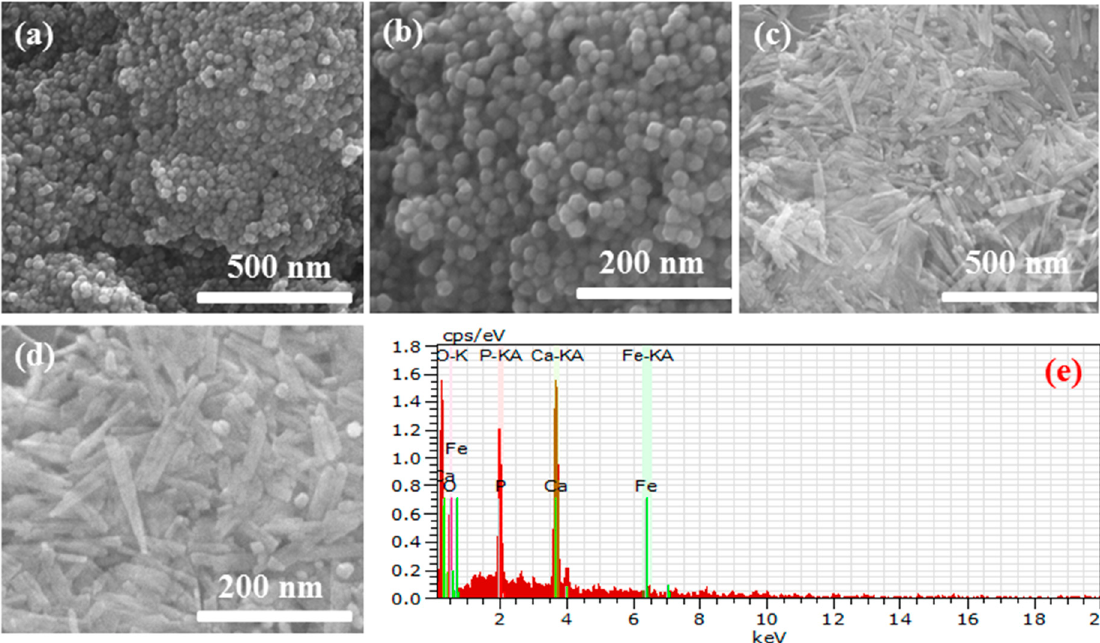
Figure 3. Field emission scanning electron microscopy (FESEM) images of Fe 3 O 4 nanoparticles ( a , b ); Fe 3 O 4 /HAp nanocomposites ( c , d ) and ( e ) EDS spectrum of Fe 3 O 4 /HAp nanocomposites.